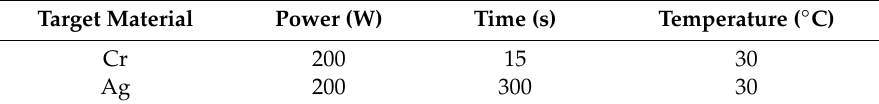
Table 1. Magnetron sputtering parameters.